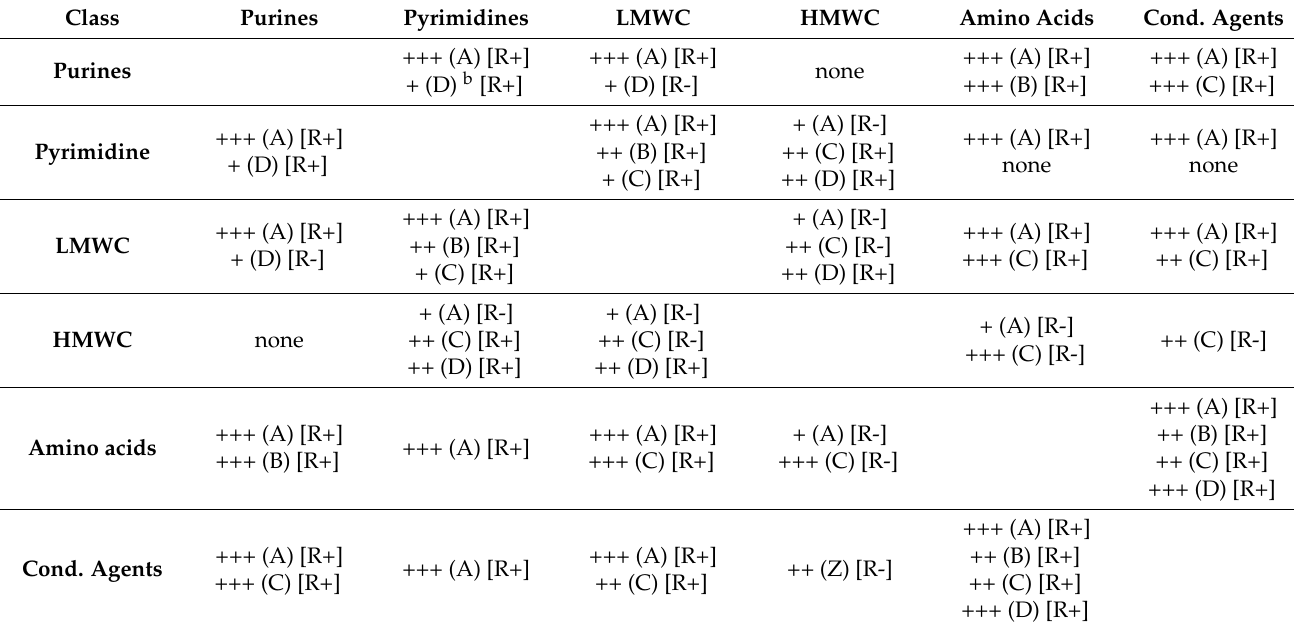
Table 3. Product-to-product relationships as calculated for the synthesis of biogenic molecules from HCONH 2 in the presence of meteorites and different energy sources a